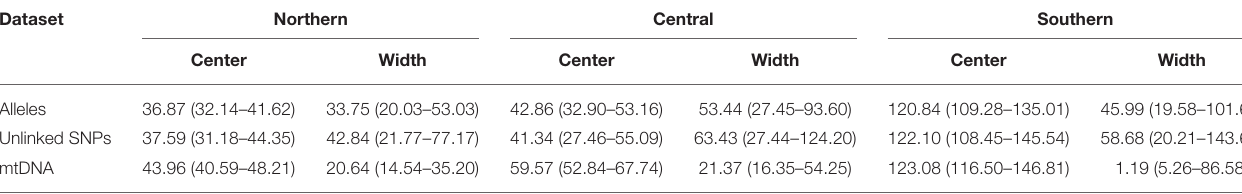
TABLE 1 | Cline analysis results from Hzar for Northern, Central, and Southern hybrid zones. Dataset